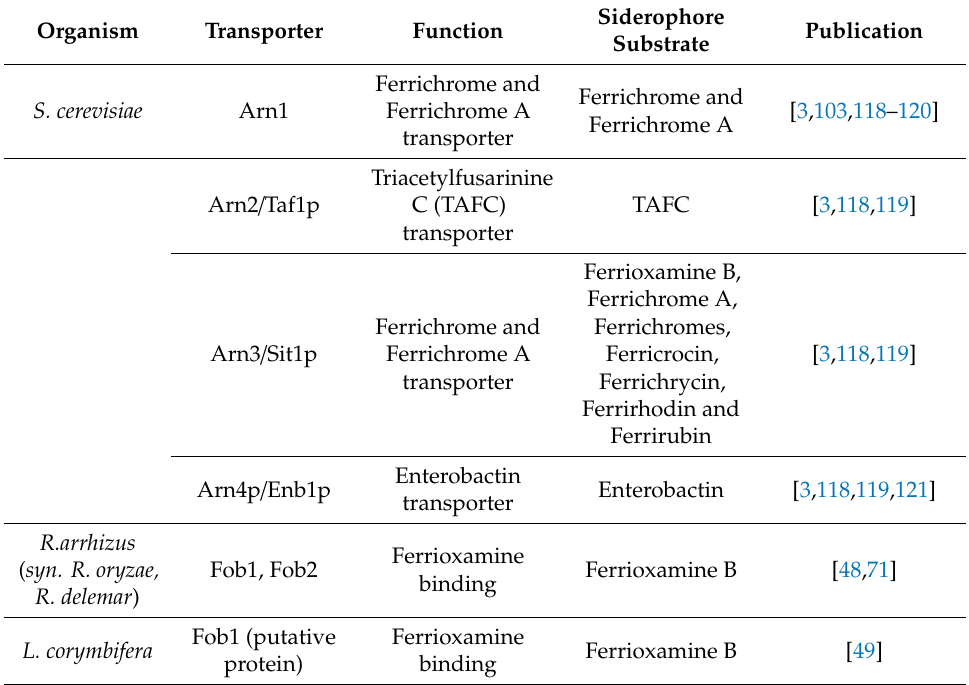
Table 2. Components of the siderophore transport system in S. cerevisiae and in pathogenic Mucoralean